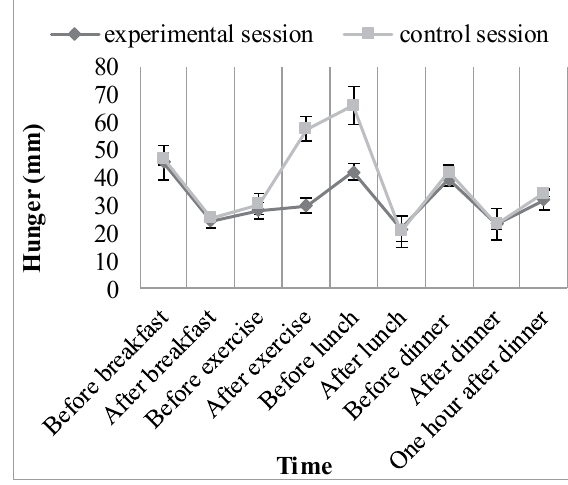
Figure 4 . Rating of hunger in the control and experimental session. Values are mean±SD (n=10).